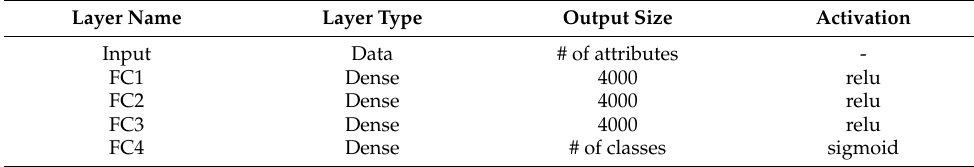
Table 3. FC layers